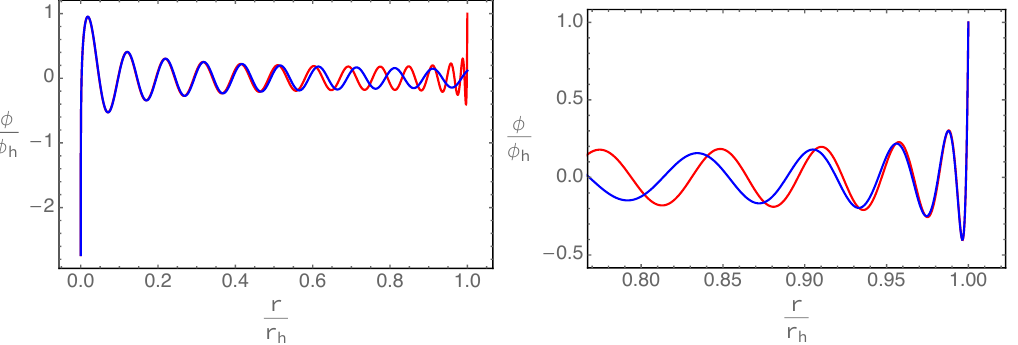
Figure 8 . Plots of the solutions for the scalar filed obtained numerically ( red ) and analytically ( blue ) near the singularity ( left ) and the horizon ( right ).